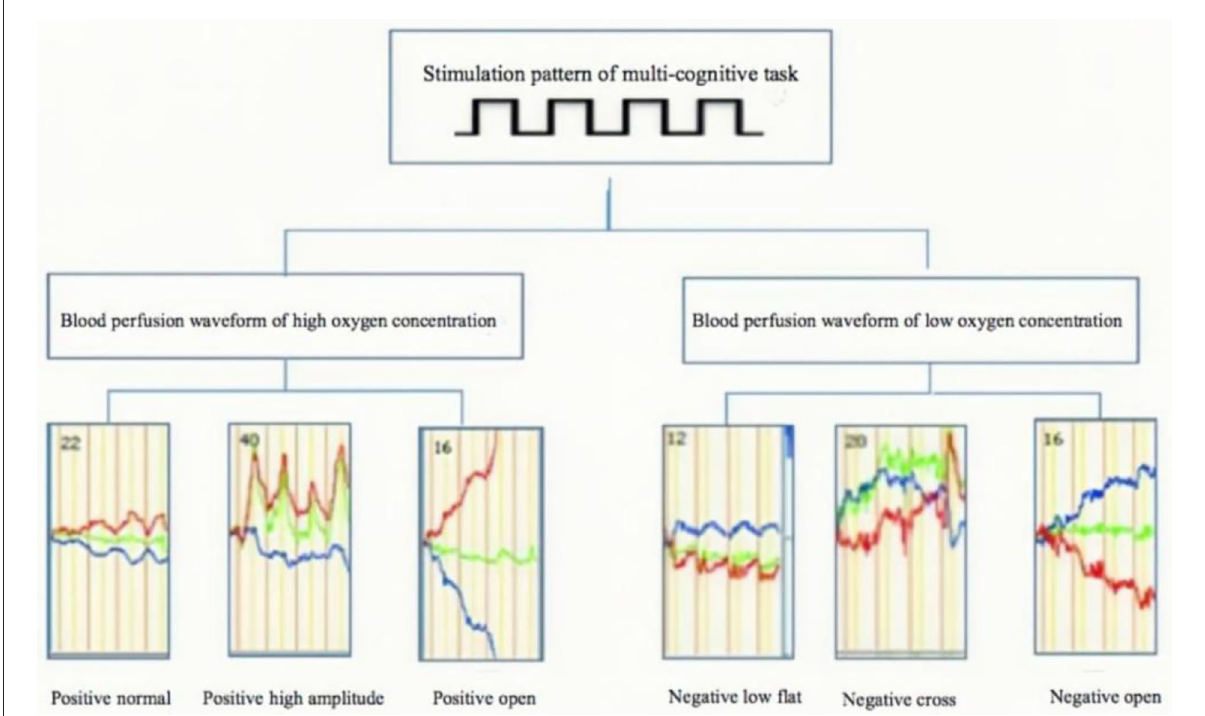
FIGURE2 Hyperbolic waveform of multi-channel [oxy-Hb] and [deoxy-Hb] blood